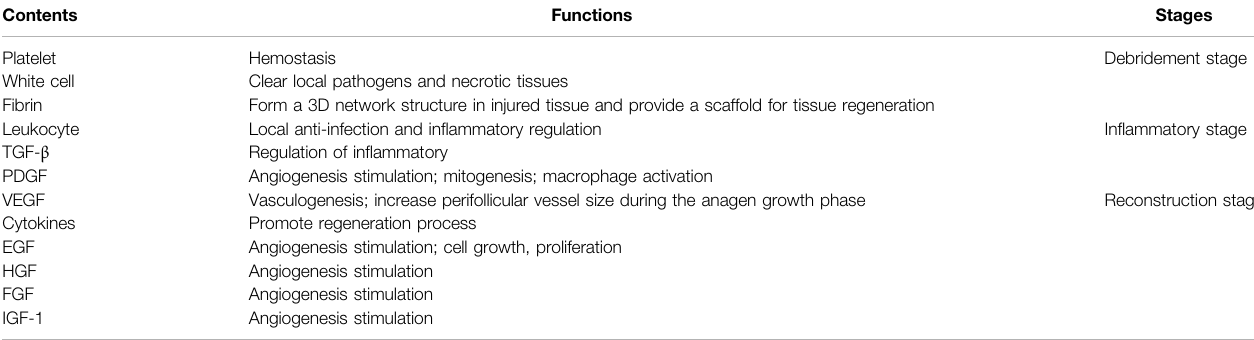
TABLE 2 | Summary of the components of PRP.